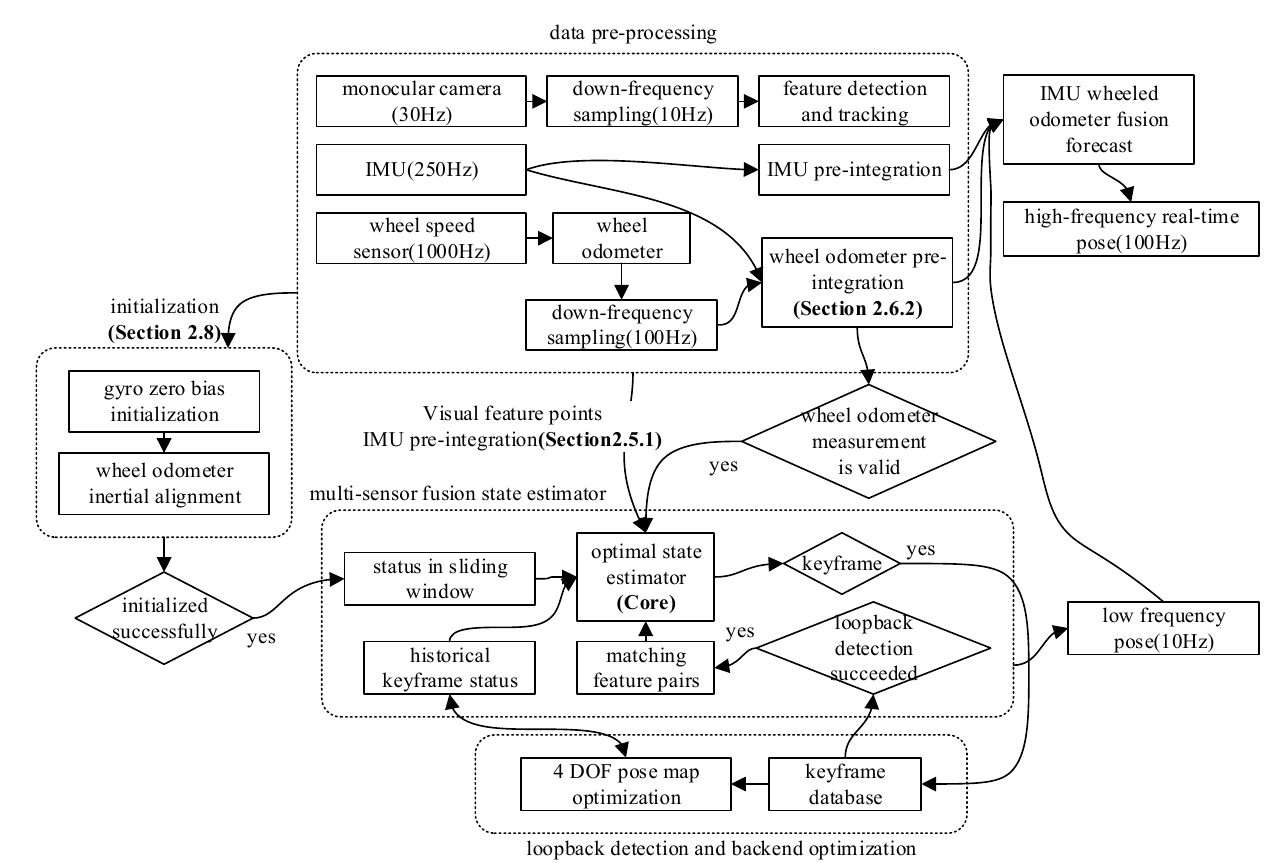
Figure 1. Block diagram of monocular vision inertial SLAM.